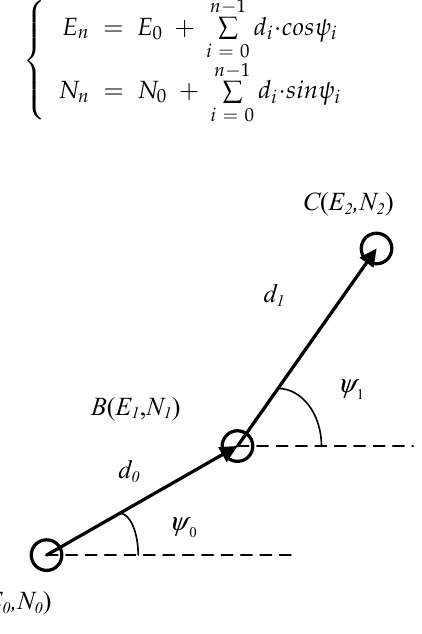
Figure 2. Track positioning.